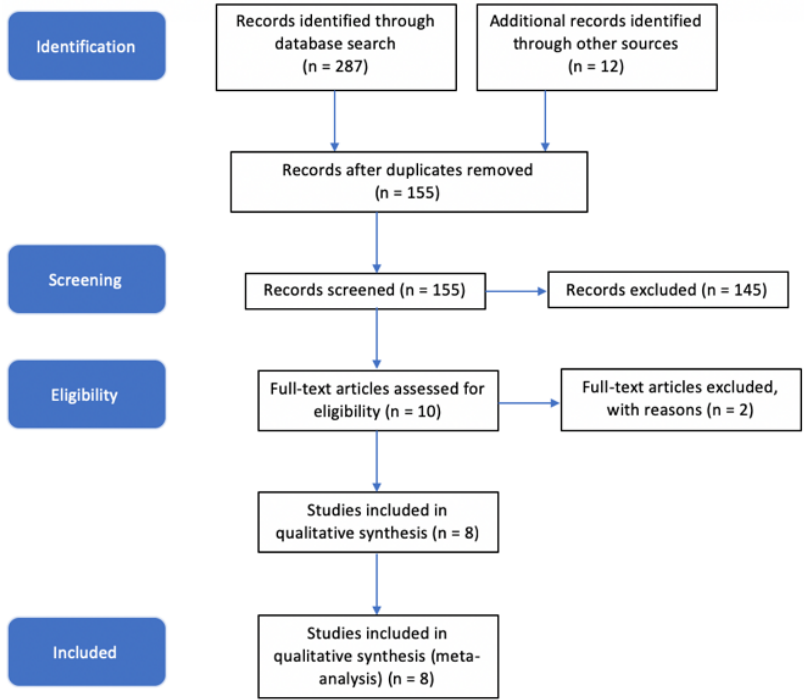
Figure 1. Results of systematic review-based literature search.